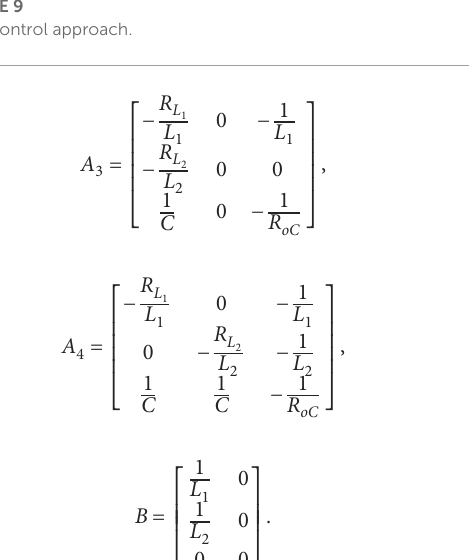
FIGURE 9 Main control approach.